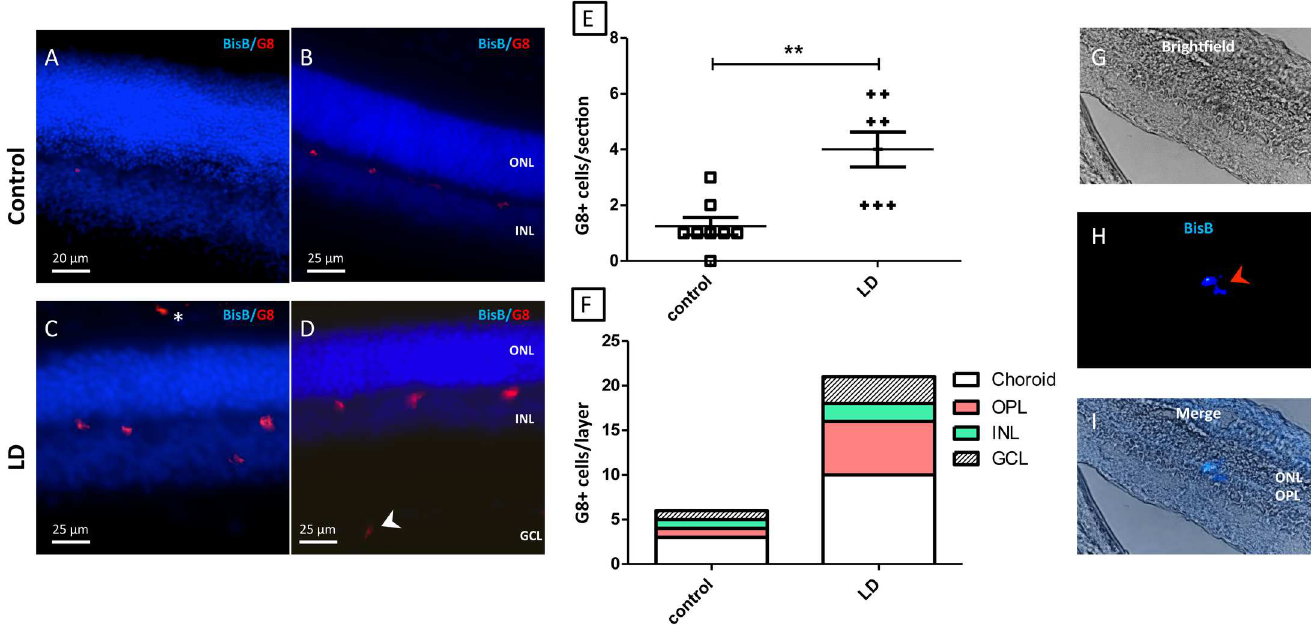
Fig 2. Endogenous Myo/Nog cells increasefollowing light damage. Sections from light damagedand control retinas were labeledwith the G8 mAb (red) and bisbenzimide dye (blue). (A, B) Representative section of from a control retina showingthe presenceof Myo/Nog cells in the OPL. C/D: Representative section of a light damagedretina showingG8+ cells Myo/Nog cells in the OPL, INL, RPE ( * ) and GCL ( ˂ ). E: The numbers of G8+ cells per section of control (squares) and LD retinas More G8+ cells were present in the LD than control retinas. ** p= 0.02 (n = 8). F: Distributionof Myo/Nog cells per retinal layer in control and LD retinas. (G-H) LD eyes were injectedwith Myo/Nog cells that had been prelabeledwith bisbenzimide 33342(blue). At 2 days post-injection, eyes were sectionedand labeledwith the G8 mAb. Myo/Nog cells were identifiedby localizingbisbenzimide. (G) Brightfield image, (H) Fluorescent image showingthe presenceof a bisbenzimide 33342+/G8+ cell s (red arrow). (I) Mergedimage showingthe locationof the bisbenzimide labeledMyo/Nog cell within the OPL. LD, light damage;ONL, outer nuclear layer; OPL, outer plexiform layer; INL, inner nuclear layer; GCL, ganglioncell